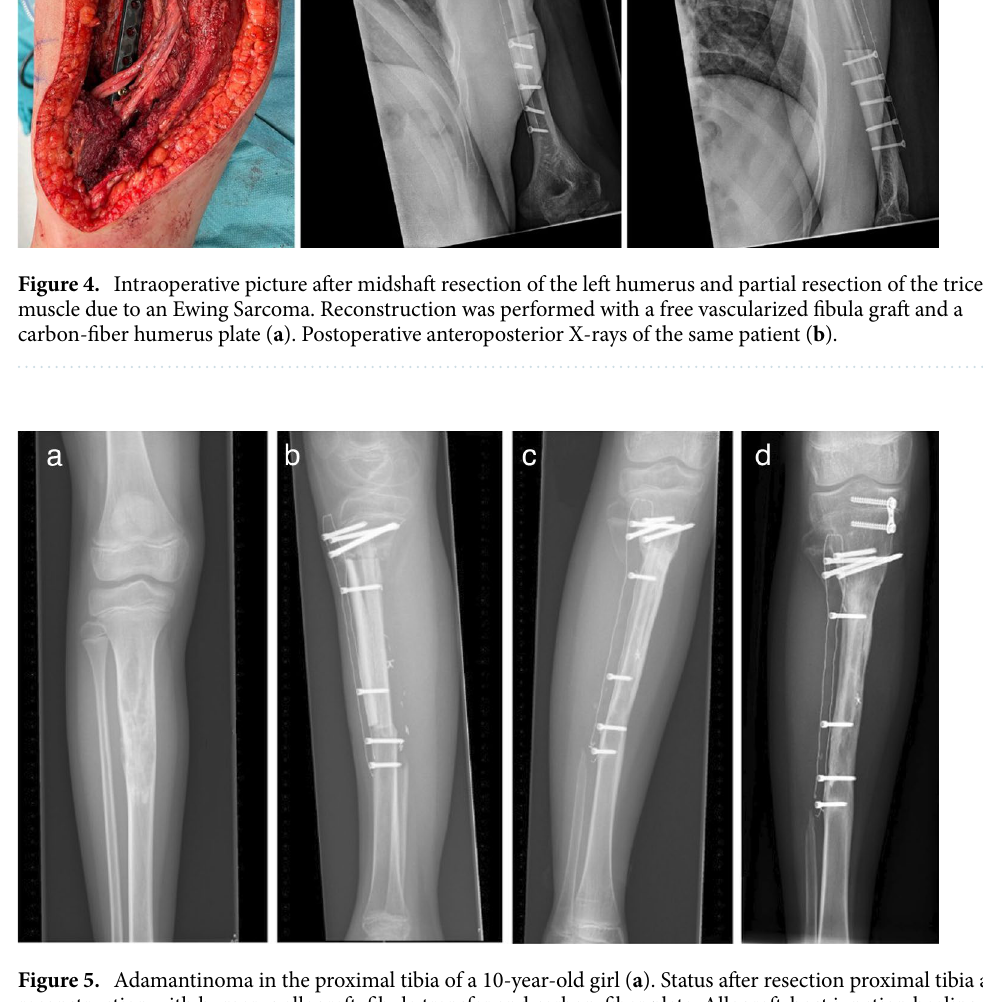
Figure 5. Adamantinoma in the proximal tibia of a 10-year-old girl ( a ). Status after resection proximal tibia and reconstruction with humerus allograft, fibula transfer and carbon-fiber plate. Allograft-host junction healing